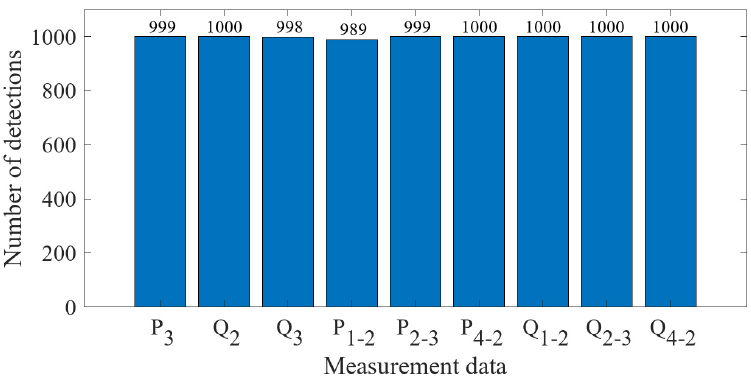
Figure 18. Detection results of false